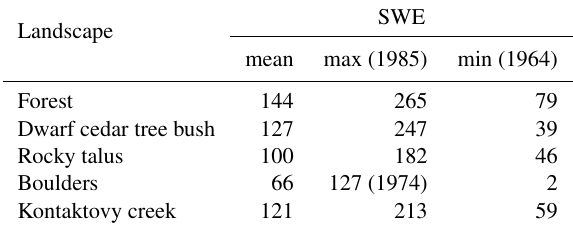
Table 3. Mean, maximum and minimum observed snow water equivalent (SWE) (mm) before spring freshet at different land- scapes of the Kontaktovy creek watershed, 1960–1997.